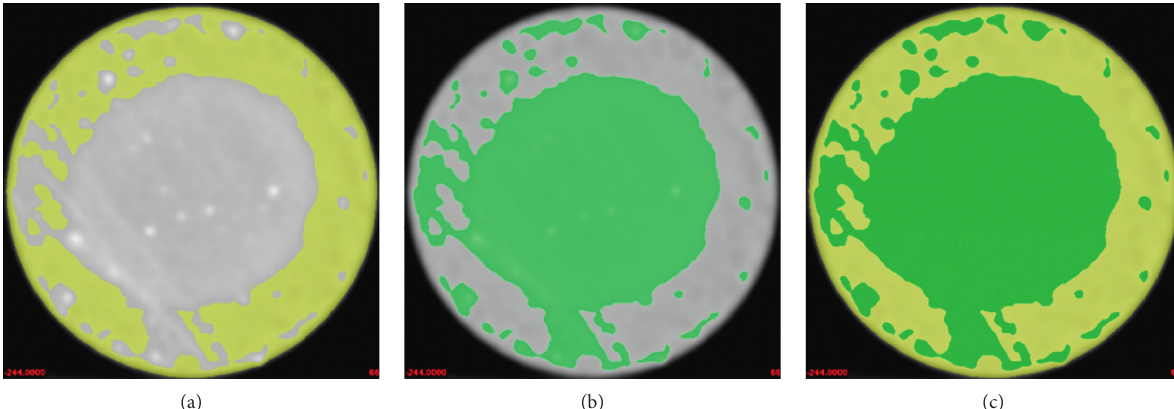
Figure 7: Two-dimensional CTimage of the acid-corroded sandstone after segmentation. (a) Corroded area selection. (b) Uncorroded area selection. (c) Rock sample slice as a whole.